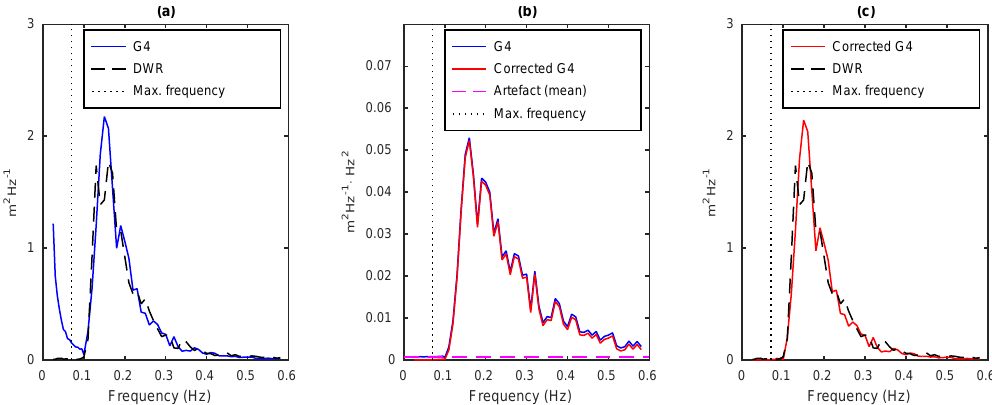
Figure 8. An example of the correction applied to a wave spectrum from a G4 wave buoy (14 May 2015). The original spectrum (a) , the spectrum scaled by f 2 and the level of the mean trend (b) and the corrected de-scaled spectrum (c) . The spectrum from the DWR is shown for comparison. The dotted line indicates the maximum frequency (0.07Hz) used to determine the level of the erroneous trend.